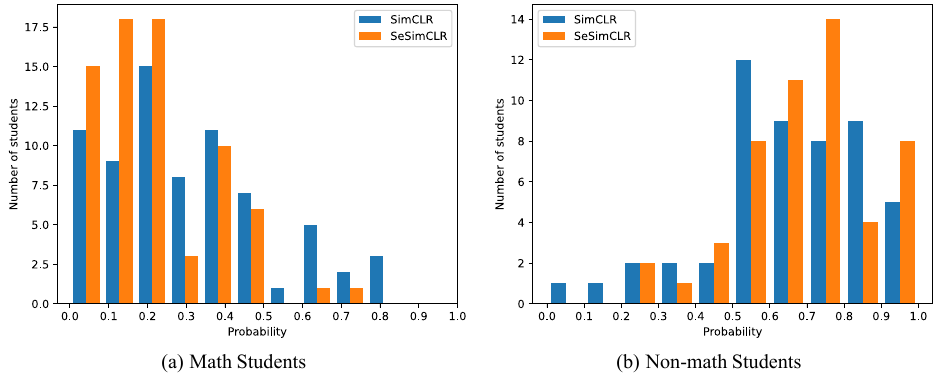
Figure 5. Histograms of classification probabilities. The number of students counts the students with the corresponding probability of belonging to class 1.